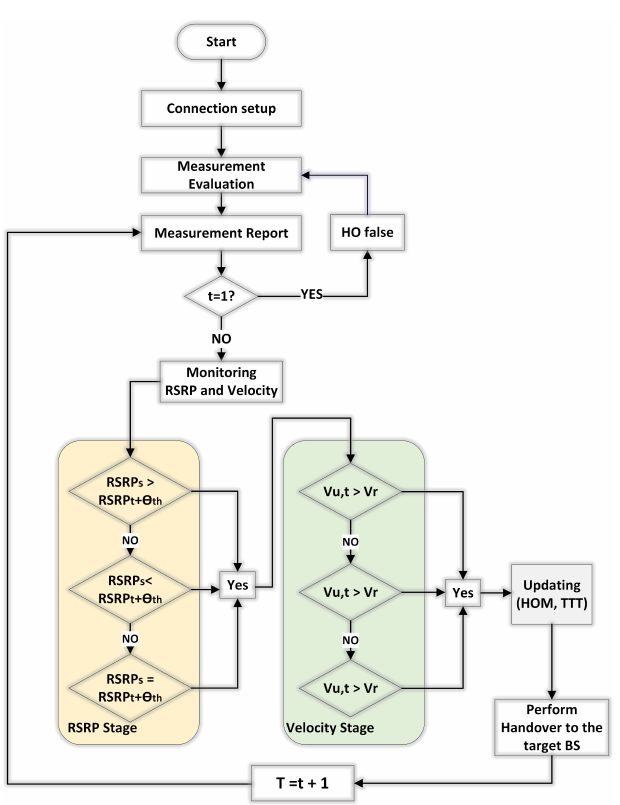
Figure 2. Flowchart of the proposed